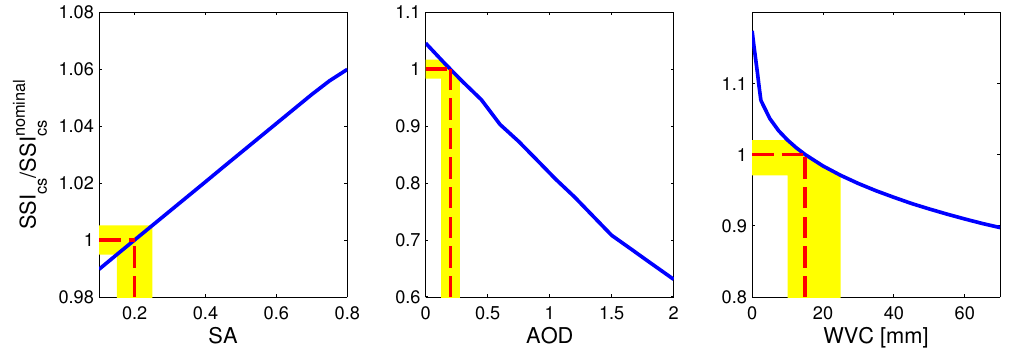
Figure 2. Sensitivity of the MAGIC computed clear-sky SSI with respect to the surface albedo (SA), the aerosol optical depth (AOD) and the atmospheric water vapor content (WVC). Values are normalized with respect to the daily integrated clear-sky SSI computed over Belgium with the nominal values for the 3 parameters (i.e., SA = 0.2, AOD = 0.2 and WVC =